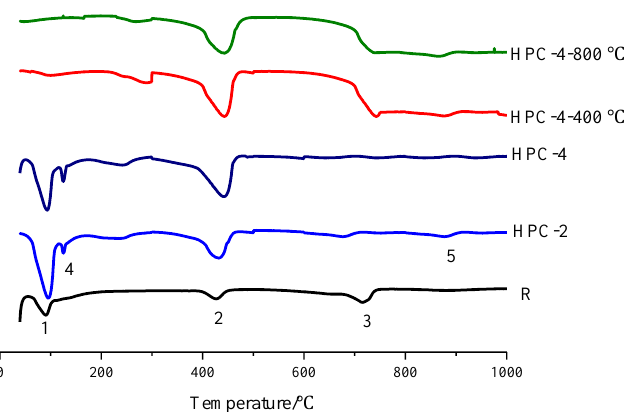
Figure 7. Di ff erential Thermal Analysis (DTA) curves for the reference concrete, HPC-2 and HPC-4 after 28 d of Figure 7. Differential Thermal Analysis ( DTA ) curves for the reference concrete, HPC-2 and HPC-4 after 28 d of curing.